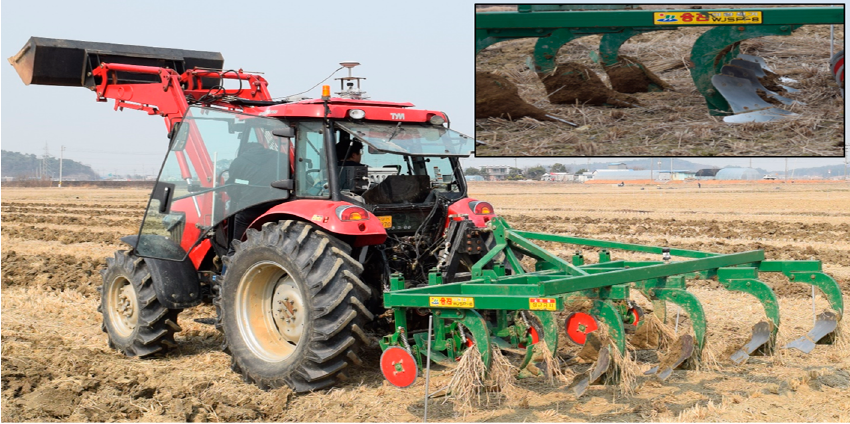
Table 2. Operating conditions of the tractor, and soil environmental conditions of the field site.